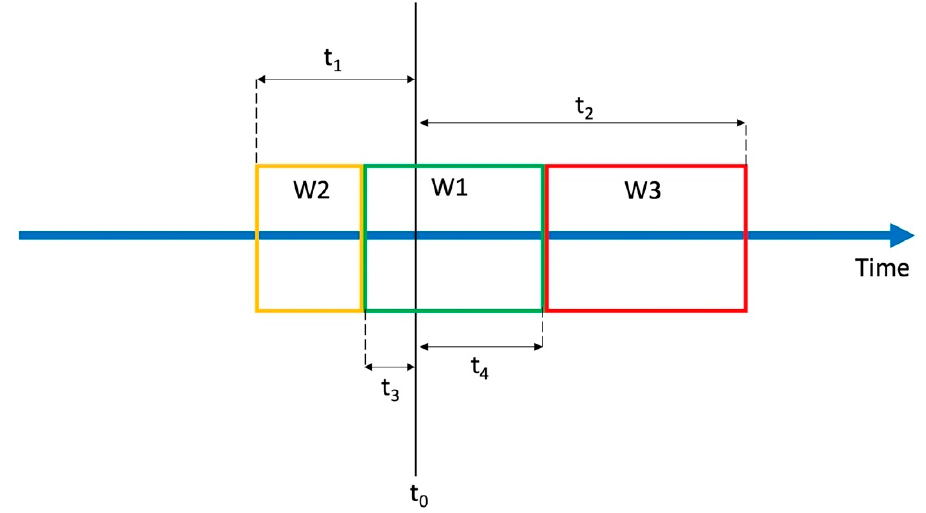
Figure 6. The model for testing different window configurations in event-centered data segmentation; t 0 marks the occurrence of a potential fall event. Parameters t 1–4 determine the time between t 0 and the beginning or the end of a window.